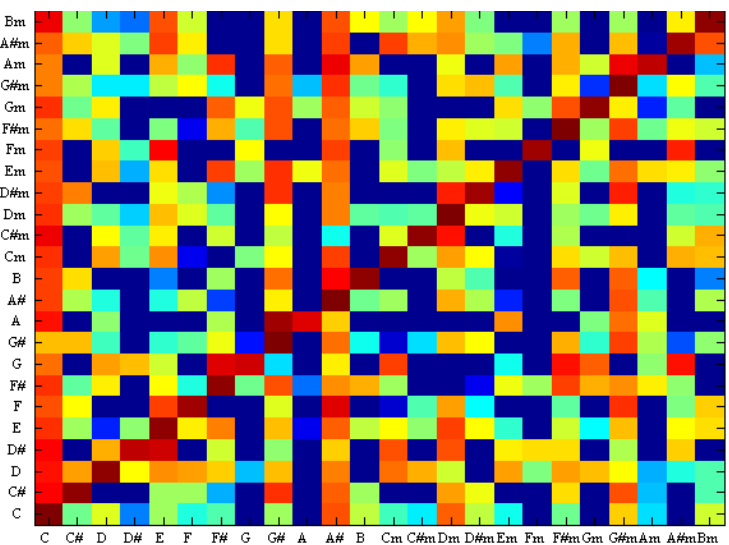
Figure 11. Confusion between chords with TCSVM.